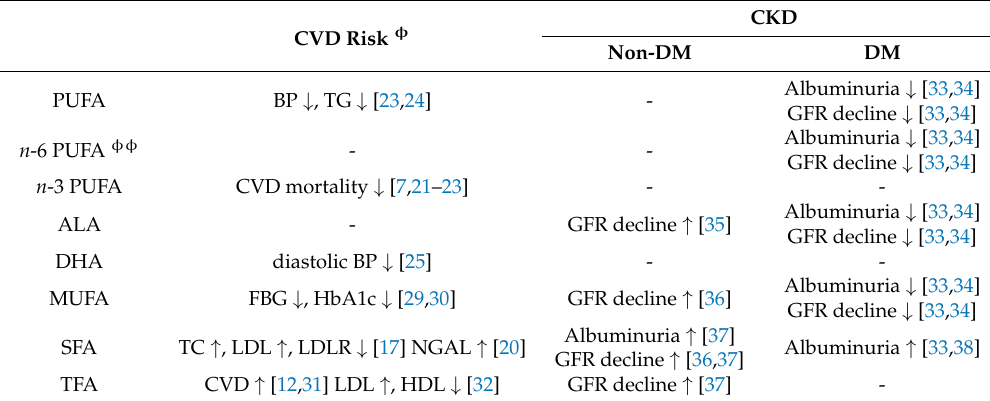
Table 1. Impact of dietary fatty acids (FAs) on cardiovascular disease (CVD) risk and chronic kidney disease